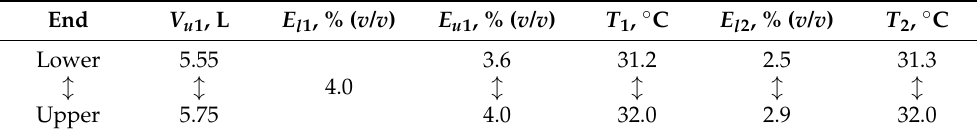
Table 11. Upper and lower end of the ranges over which the operational variables minimized P m est .